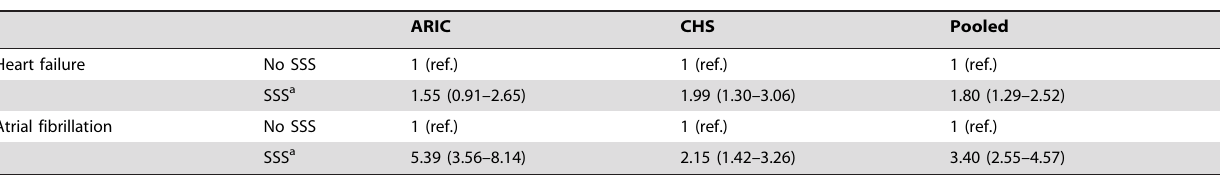
Adjustment for pacemaker implantation as a time-dependent covariate ARIC CHS Pooled Heart